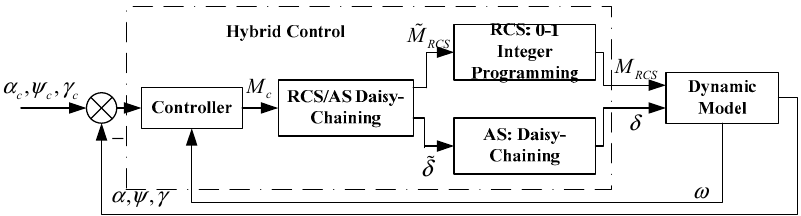
Figure 2. The structure diagram of the daisy-chaining allocation scheme.